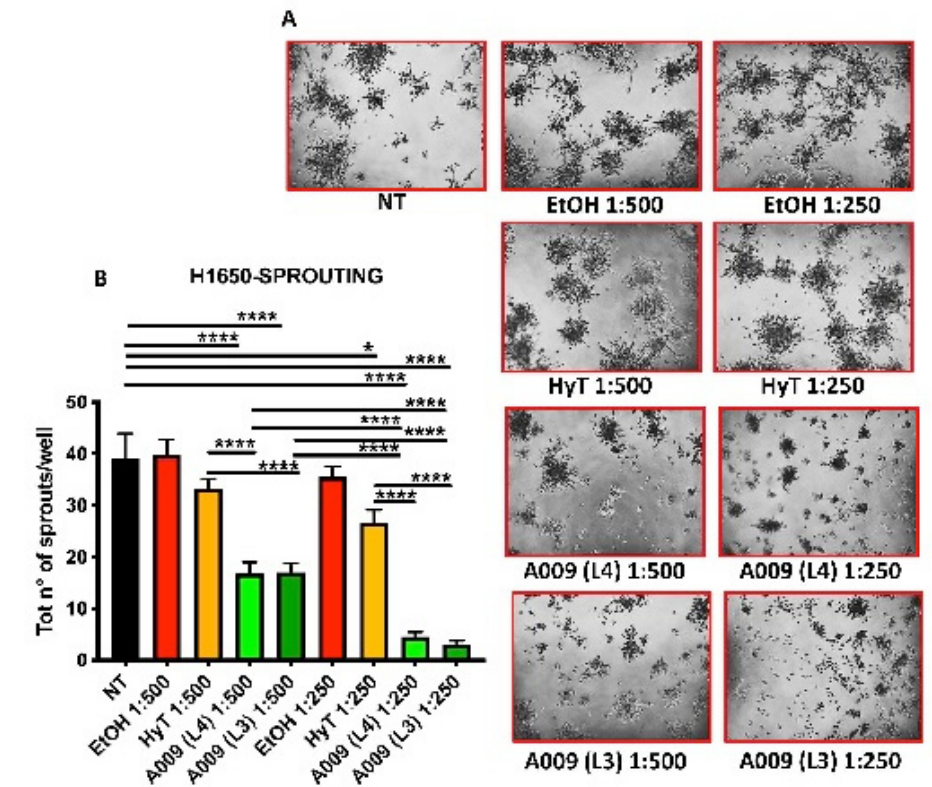
Figure 4. E ff ect of A009 extract in interfering with pro-metastatic cellular activity in vitro, in lung carcinoma cell. The lung carcinoma cell line H1650 (15.000 cells / well) was seeded in wells containing Matrigel (10 mg / mL) and treated for 48 h with 2 batches of A009 (L4 and L3), at dilutions 1:500, 1:250, or with hydroxytytosol (HyT) at the same concentration present in the dilutions of A009. The same magnification is reported for each well (10x objective). The e ff ect on the formation of invasive structures (sprouts) ( A ) was determined by counting the absolute number of branches present for each cell spheroid, using ImageJ image analysis software ( B ). Results are shown as mean ± SEM, One Way ANOVA, * p < 0.5, **** p < 0.0001. NT (untreated); EtOH (ethanol vehicle used to